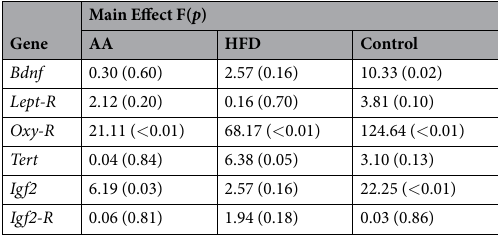
Table 3. Statistical results for the one-way ANOVAs that examined differences in promoter methylation in sperm and brain obtained from